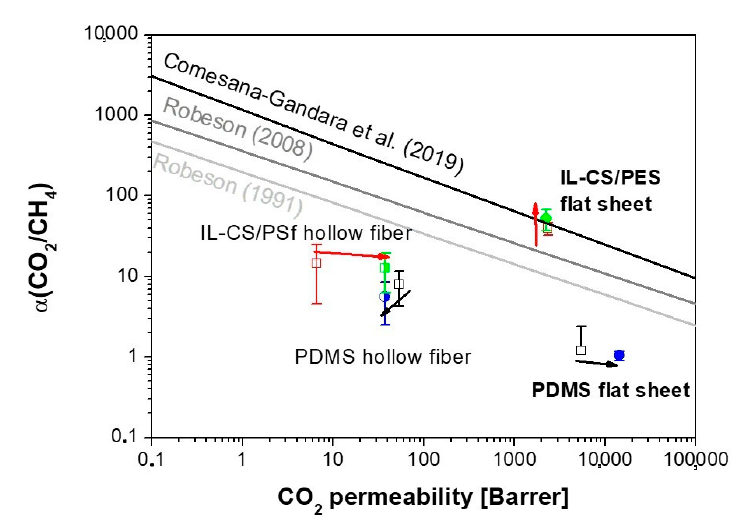
Figure 2. E ff ect of morphology on the CO 2 / CH 4 separation performance of the fresh hydrophobic PDMS and hydrophilic ionic liquid–chitosan (IL–CS) composite membranes, against the CO 2 / CH 4 upper